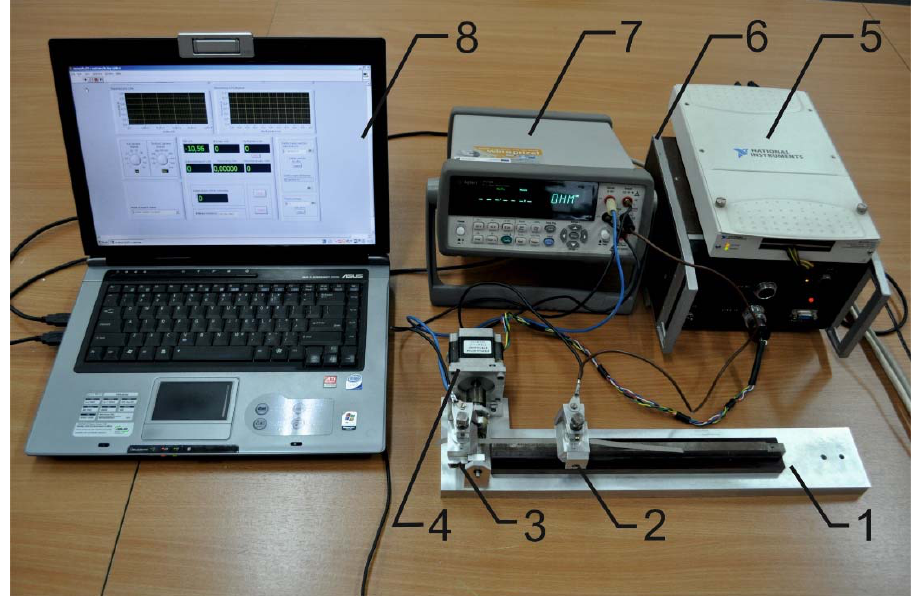
Figure 4. The stand for cyclical bending.